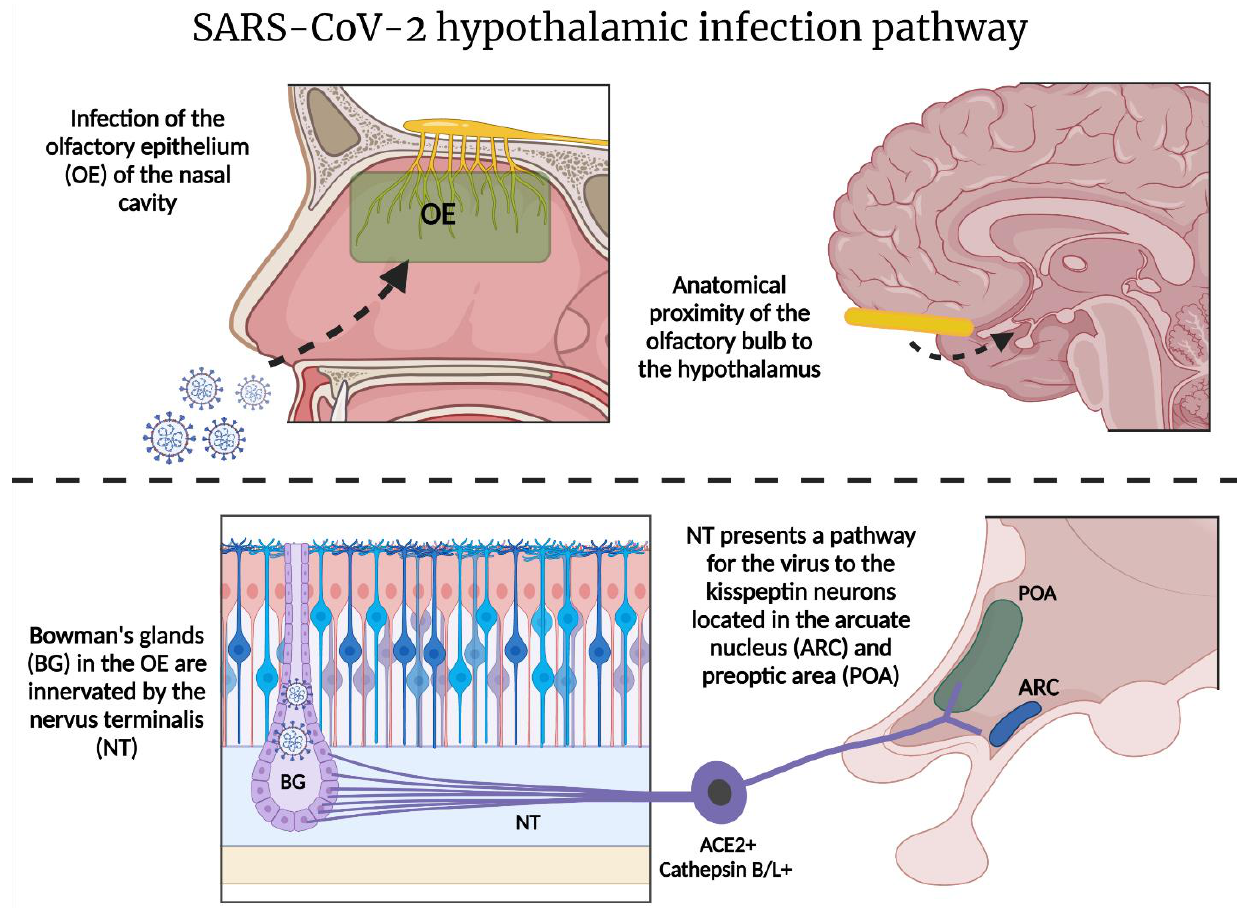
Figure 4. Theoretical SARS-CoV-2 hypothalamic infection pathway: SARS-CoV-2 could utilize the olfactory epithelium for host entry [83]. Anosmia is a common symptom in COVID-19, and axonal transport through the olfactory nerve has been proposed as the mechanism. Nonetheless, most olfactory sensory neurons do not express the required proteins, and lack the projections needed to reach targets in the brain [44]. The olfactory epithelium, however, expresses entry proteins necessary for SARS-CoV-2 [83]. Alternatively, the nervus terminalis (NT) may potentially provide a direct route to critical brain targets such as the hypothalamus. NT afferent fibers innervate the Bowman’s glands and express both ACE2 and cathepsins B and L [44]—the viral entry proteins for SARS-CoV-2. NT fibers terminate in the preoptic area (POA) of the hypothalamus [93], potentially providing SARS-CoV-2 with access to the hypothalamic neuronal network. Specifically, within the POA, a group of neurons referred to as the “kisspeptin neuronal network” (KNDy) might be affected. The KNDy neurons are mainly expressed in POA and the arcuate nucleus (ARC) [91], where they play a vital role in pituitary hormone secretion, thermoregulation, and autonomic response, and provide neuronal projections to critical limbic brain regions [94 – 97]. Figure was created with the BioRender software.